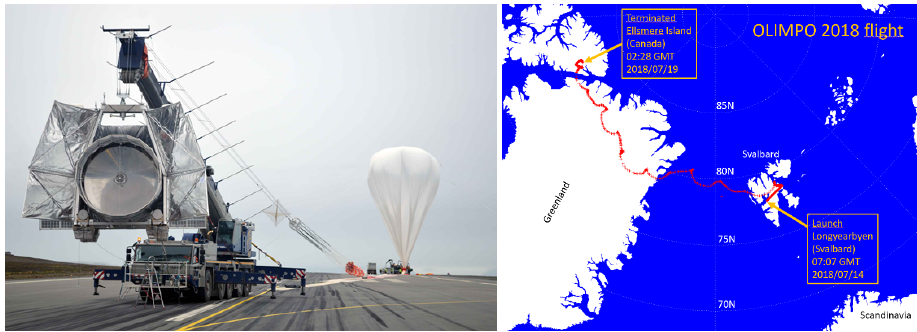
Figure 3. Launch (left) and ground path (right) of the OLIMPO